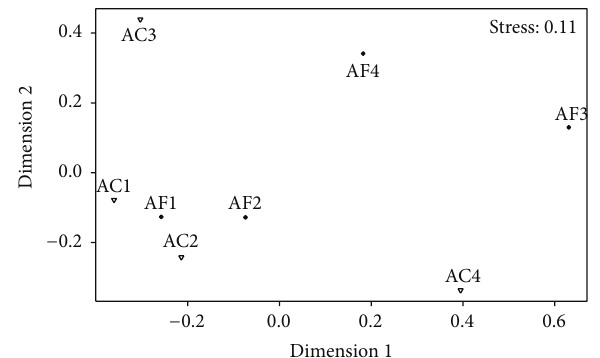
Figure 3: Results of the NMDS analysis of the species composition of the burned (AF1, AF2, AF3, and AF4) and control (AC1, AC2, AC3, and AC4) plots surveyed during the present study in eastern Acre, Brazil, based on the Bray-Curtis